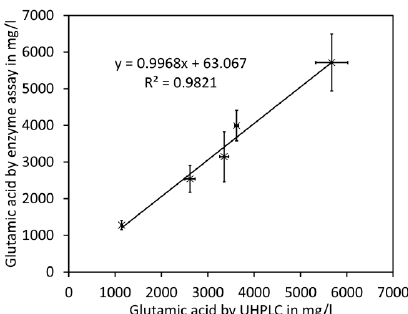
Figure 4. Comparison with enzymatic assay for glutamate. Different cultivars of cherry tomato fruits were analysed by UHPLC and enzyme test. The data shown are average values and error bars representing SD of 2 to 4 (enzyme test) or 3 (UHPLC) independent measurements (see Appendix A, Table A1 for details).